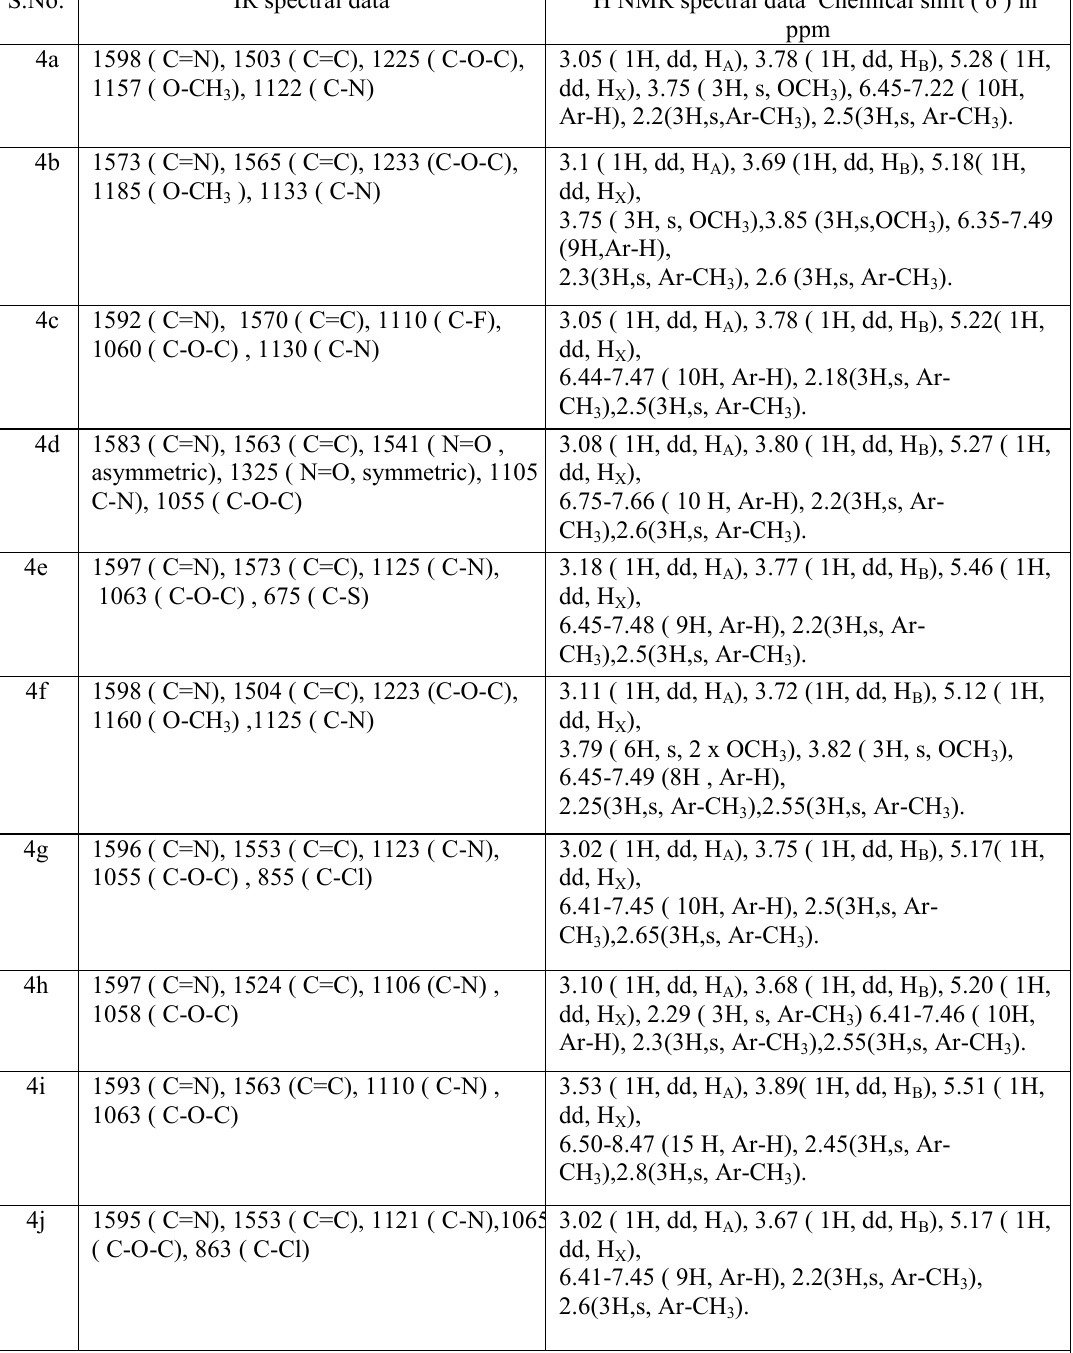
Table 2. Spectral data of the prepared compounds 4